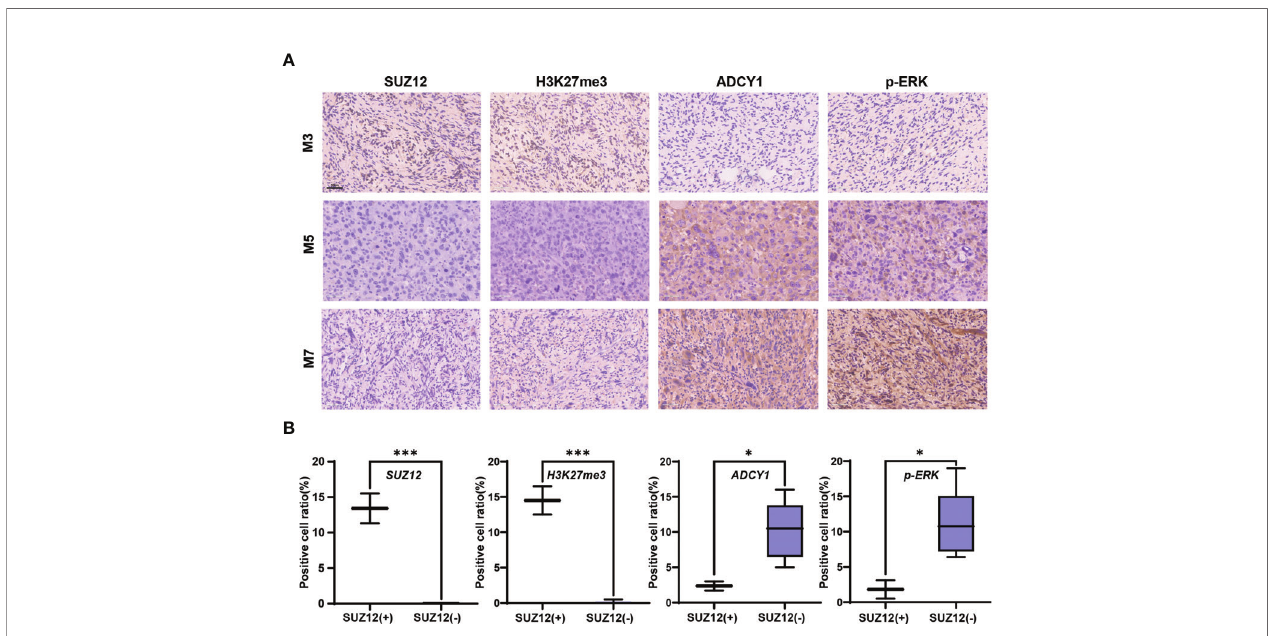
FIGURE 3 | Expression of SUZ12, H3K37me3, ADCY1 and p-ERK in MPNST tumor samples. (A) The fi gure showing immunohistochemical results of SUZ12, H3K37me3, ADCY1 and p-ERK in tumor tissues of three MPNST patients. Scale bars: 50 µm (40 x). (B) The two groups were divided into SUZ12-positive (SUZ12+) and SUZ12-negative (SUZ12-) according to SUZ12 expression, and the positive cell ratio of SUZ12, H3K37me3, ADCY1 and p-ERK were compared between the two groups by t-test. ***P < 0.001, and *P <